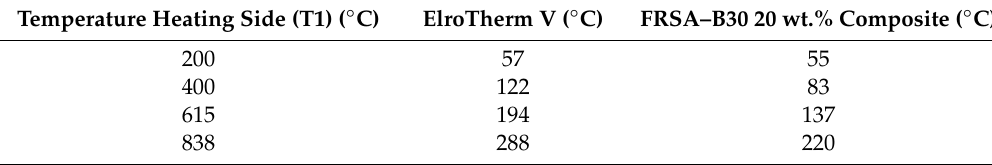
Di ff erent testing temperatures inside and outside of the testing materials on a technical